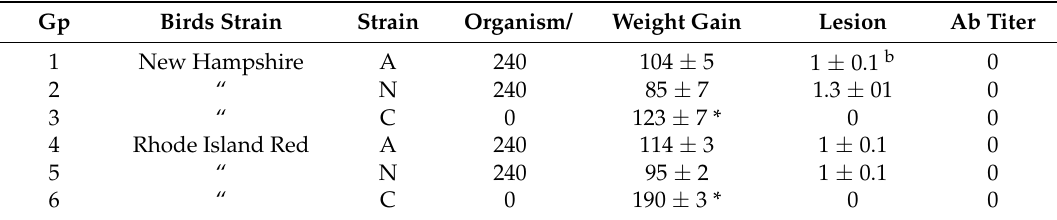
Six birds/group (Gp) were inoculated with Normal (N) or Aberrant (A) organisms (week 1). Data is shown as mean ± SEM. Normal control (C) birds received (0) sham inoculation. Lesion scores. Mean Body Weight gain/g. N = 6/group. b p < 0.05. * p < 0.01. Table 3. Animals immunized with second dose of normal or aberrant organisms. Six/group animals which were immunized with 240 and 2400 Normal (N) or Aberrant (A) organisms (week 4) with 2-weeks interval. Control (C) birds received (0) sham inoculation.